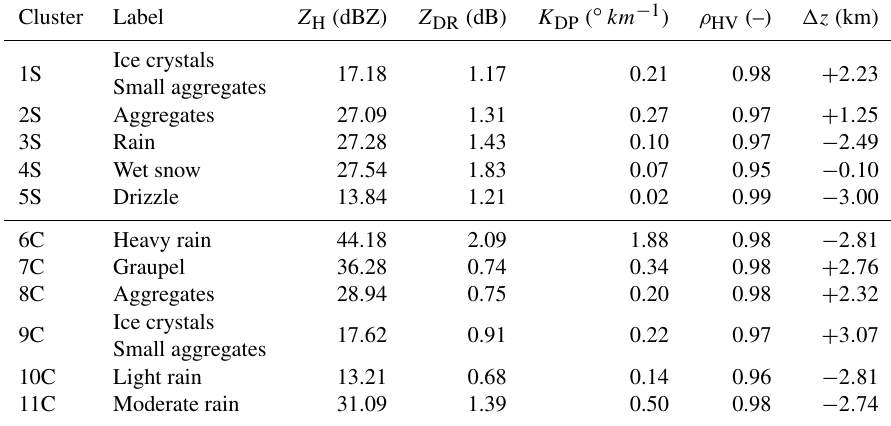
Table A1. Cluster centroids for the wet season.